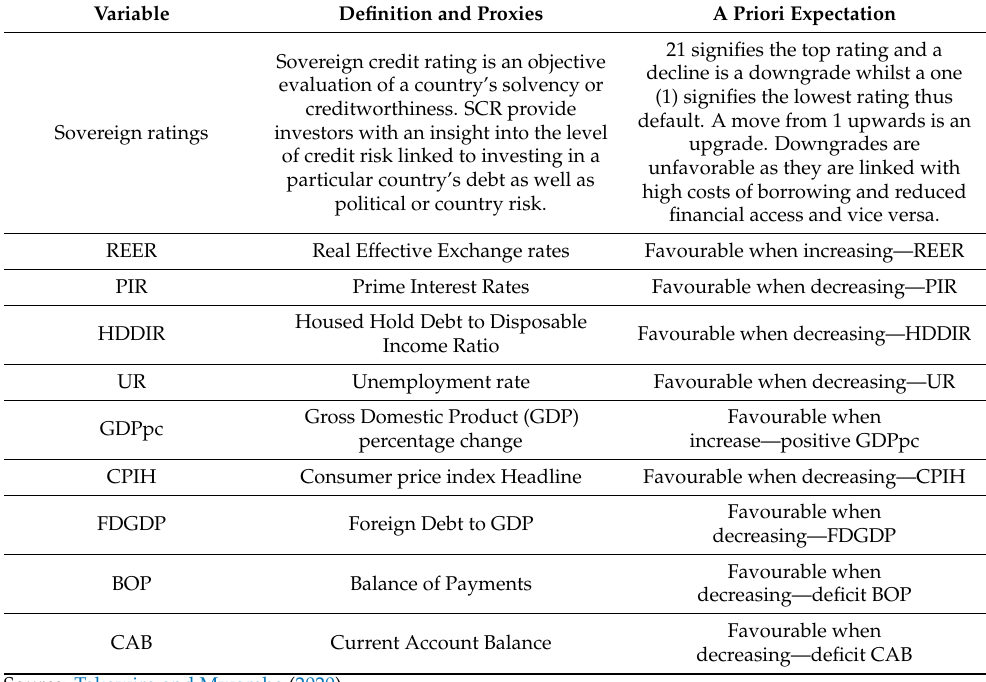
Table 1. Summarizes the variables, their definition and a priori expected